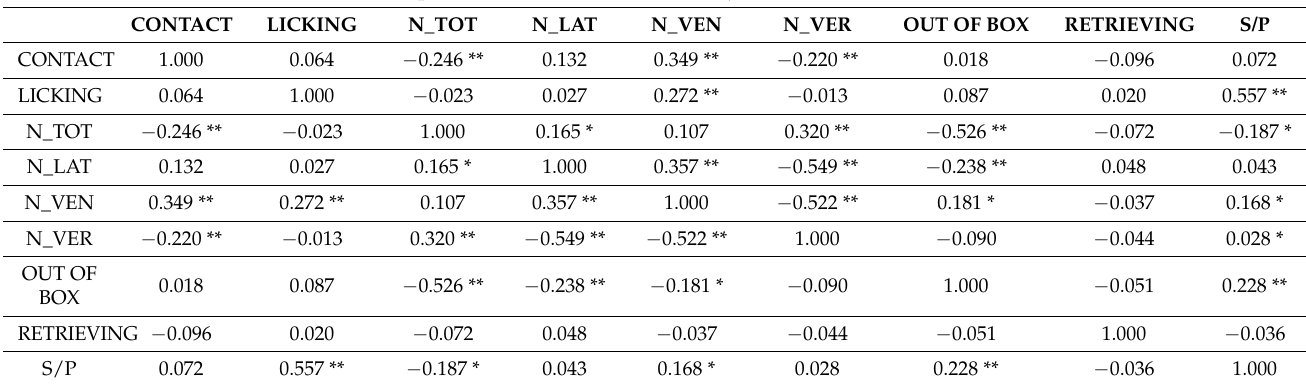
Table 5. The Spearman correlation coefficient ( (cid:36) ) between the duration of the observed maternal behaviors: Contact, licking, total nursing (N_TOT) [nursing lateral (N_LAT) + nursing ventral (N_VEN) + nursing vertical (N_VER)], retrieving, sniffing/poking (S/P), and out of box.